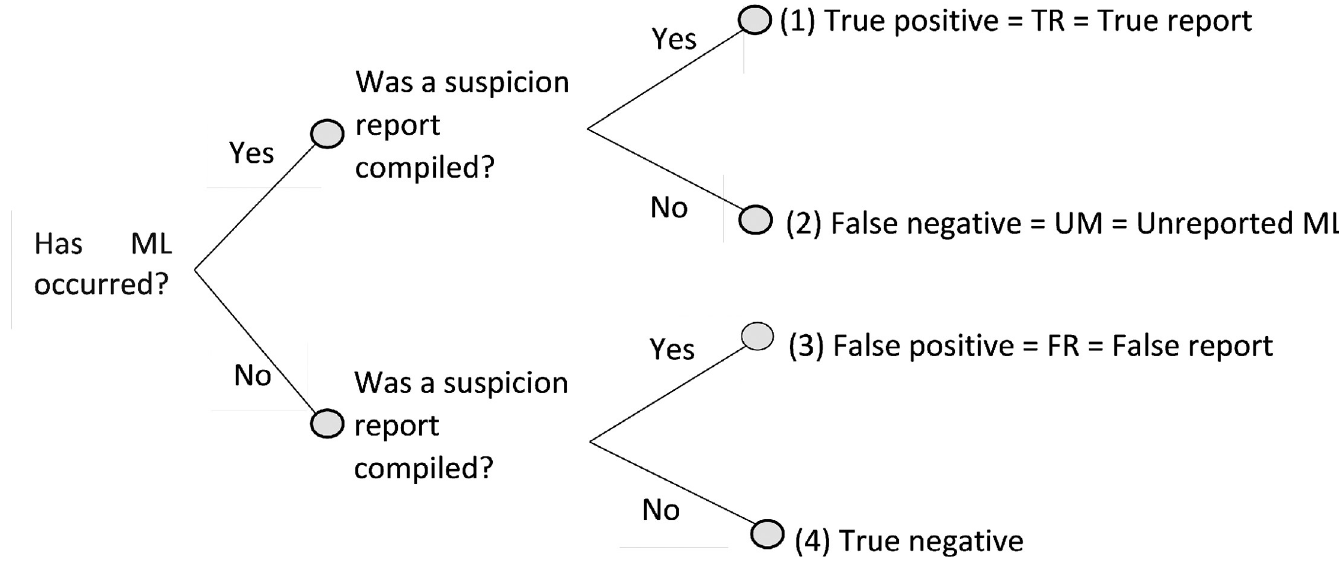
Fig 2. Event tree of reporting money laundering. ML–money laundering.